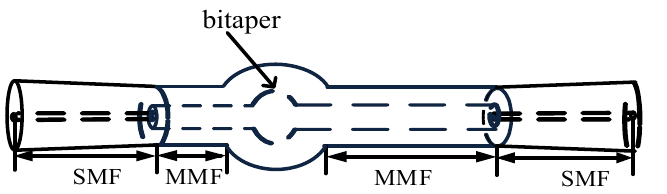
Figure 7. Schematic diagram of the ESMBMS MZI with the position of the bitaper set to one third of the sensing arm.